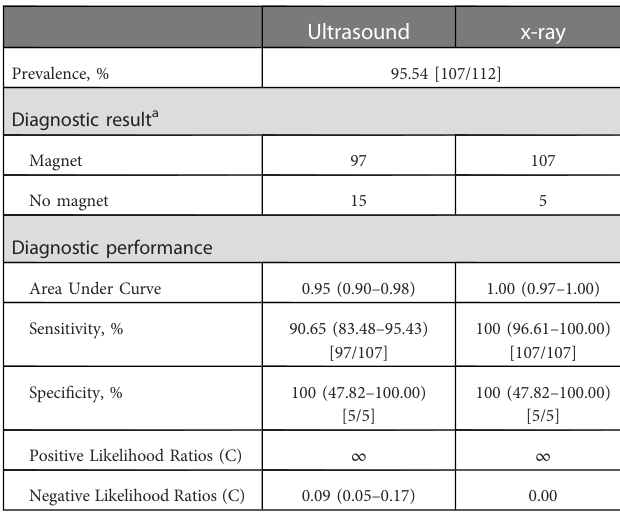
TABLE 1 Clinical characteristics and management of 112 patients. TABLE 2 Diagnostic performance between different examinations of 112 patients.